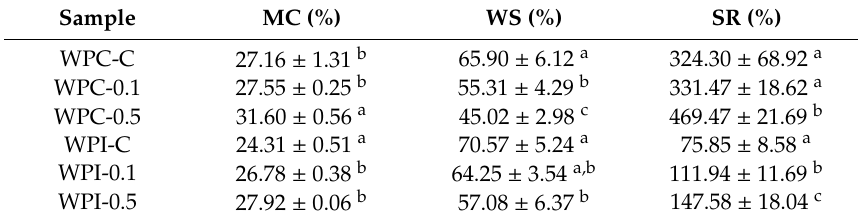
Table 1. Moisture content (MC), water solubility (WS) and swelling ratio (SR) of neat whey protein concentrate / isolate films (WPC / WPI) and melanin-modified